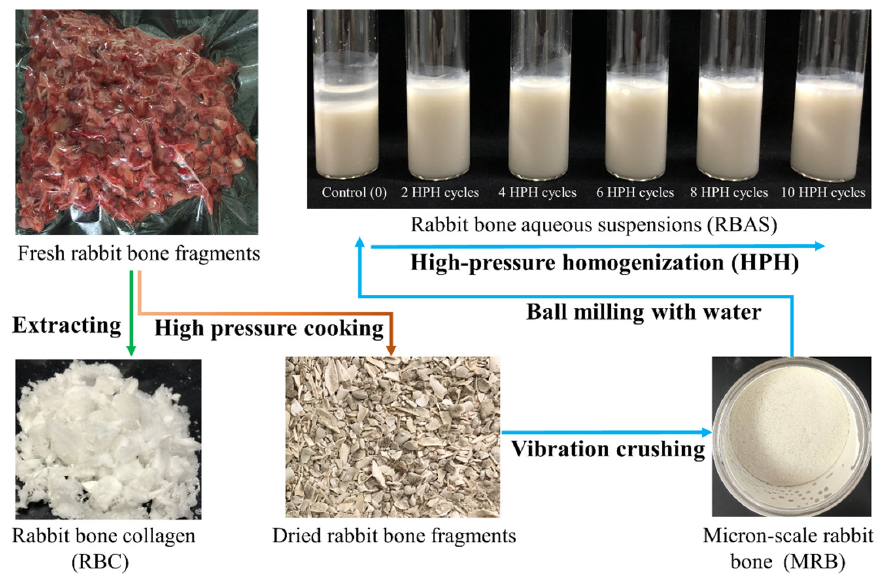
Figure 1. Schematic diagram of samples’ processing and their appearance. Fresh rabbit bone fragments were vacuum-packed. Rabbit bone collagen (RBC) was prepared by the acid dissolution method and freeze-dried in a vacuum. Micron-scale rabbit bone (MRB) was photographed in the receiving box of the vibratory crusher. The photo of rabbit bone aqueous suspensions (RBAS) was taken within 1 h after different high ‐ pressure homogenization (HPH) cycles.